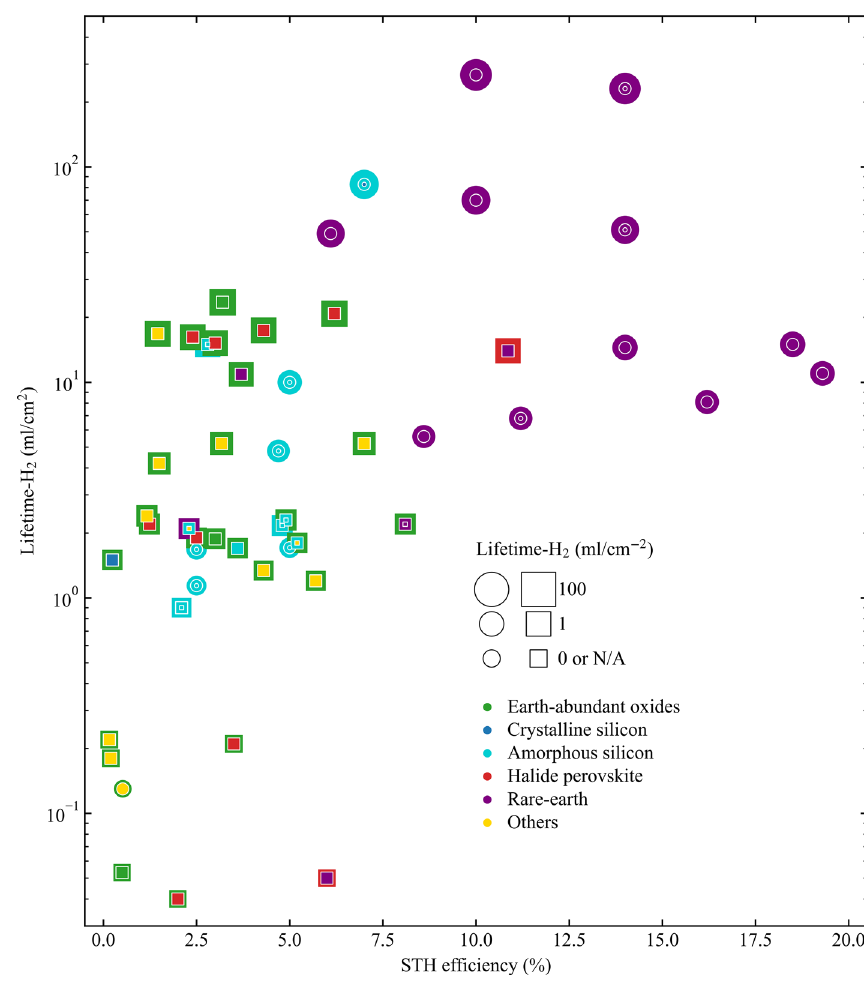
Fig. 7 STH efficiency and